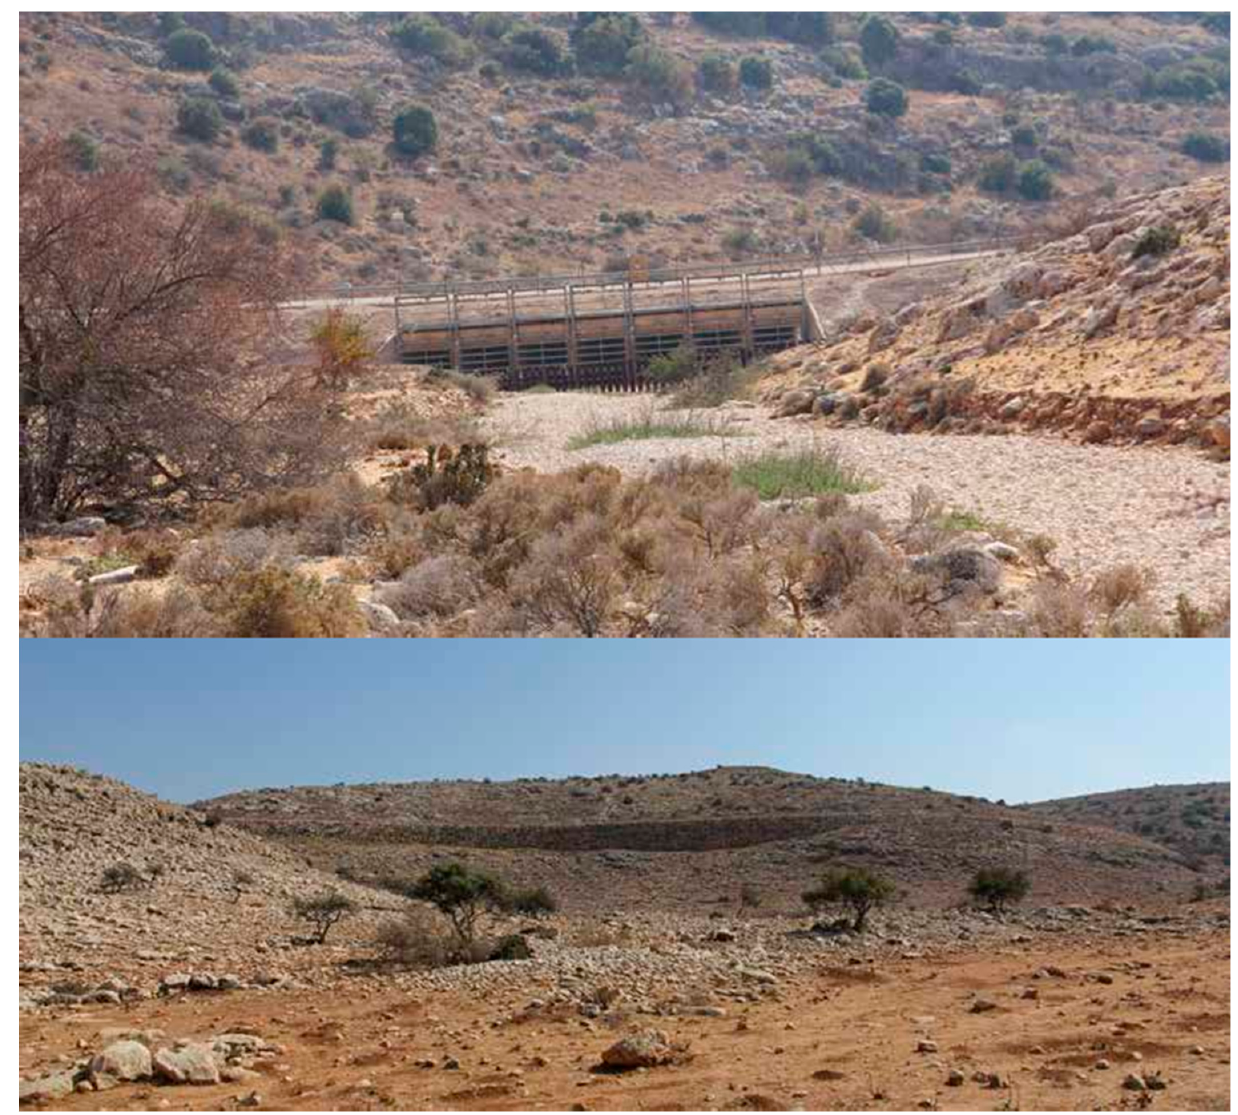
Figure 9. Segregation wall on the western part of WZ limiting the free movement of large animals on both sides.